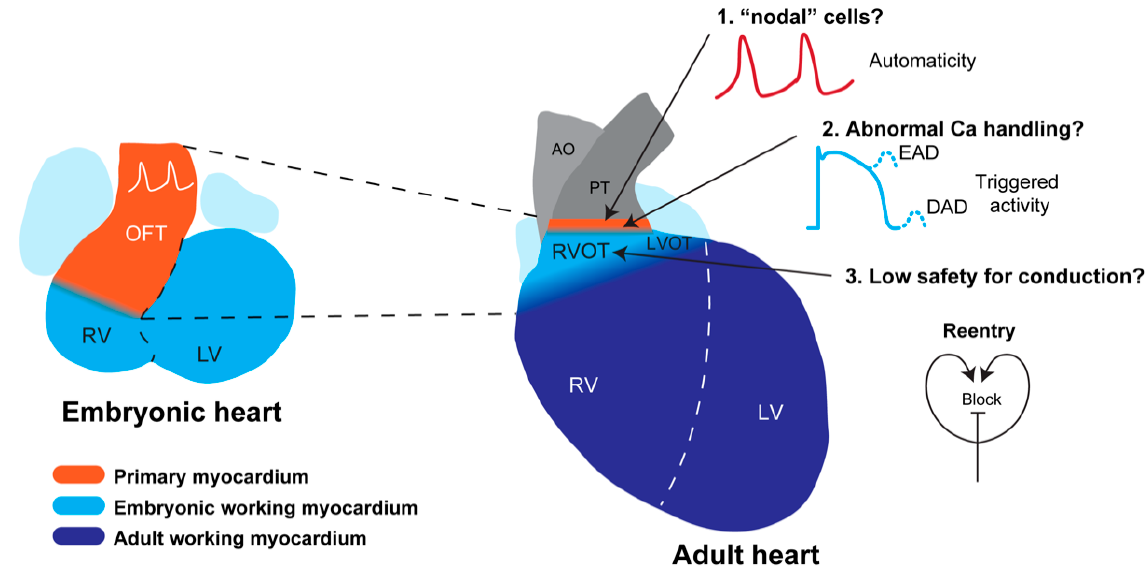
Figure 5. Developmental basis for RVOT arrhythmias. The adult RVOT has formed from the embryonic outflow tract (left), which is composed primary of myocardium exhibiting slow conduction and spontaneous activity. During development, the embryonic outflow tract acquires a working myocardial phenotype, e.g., fast conduction, and transforms into the RVOT. A small ring of primary myocardium, however, still remains just below the pulmonary valve, which may give rise to automaticity as seen in patients with idiopathic RVOT tachycardia. The myocardium of the free wall and septum of the adult RVOT has a working myocardial phenotype, although expression of Cx43 is lower than in the right ventricle. This may set the stage for re-entrant-based arrhythmias as seen in patients with the Brugada syndrome. Modified from [100] LV, left ventricle; RV, right ventricle; OFT, outflow tract; RVOT, right ventricular outflow tract; AO, aorta; PT, pulmonary trunk; LVOT, left ventricular outflow tract; Ca, calcium; EAD, early after depolarization; DAD, delayed after